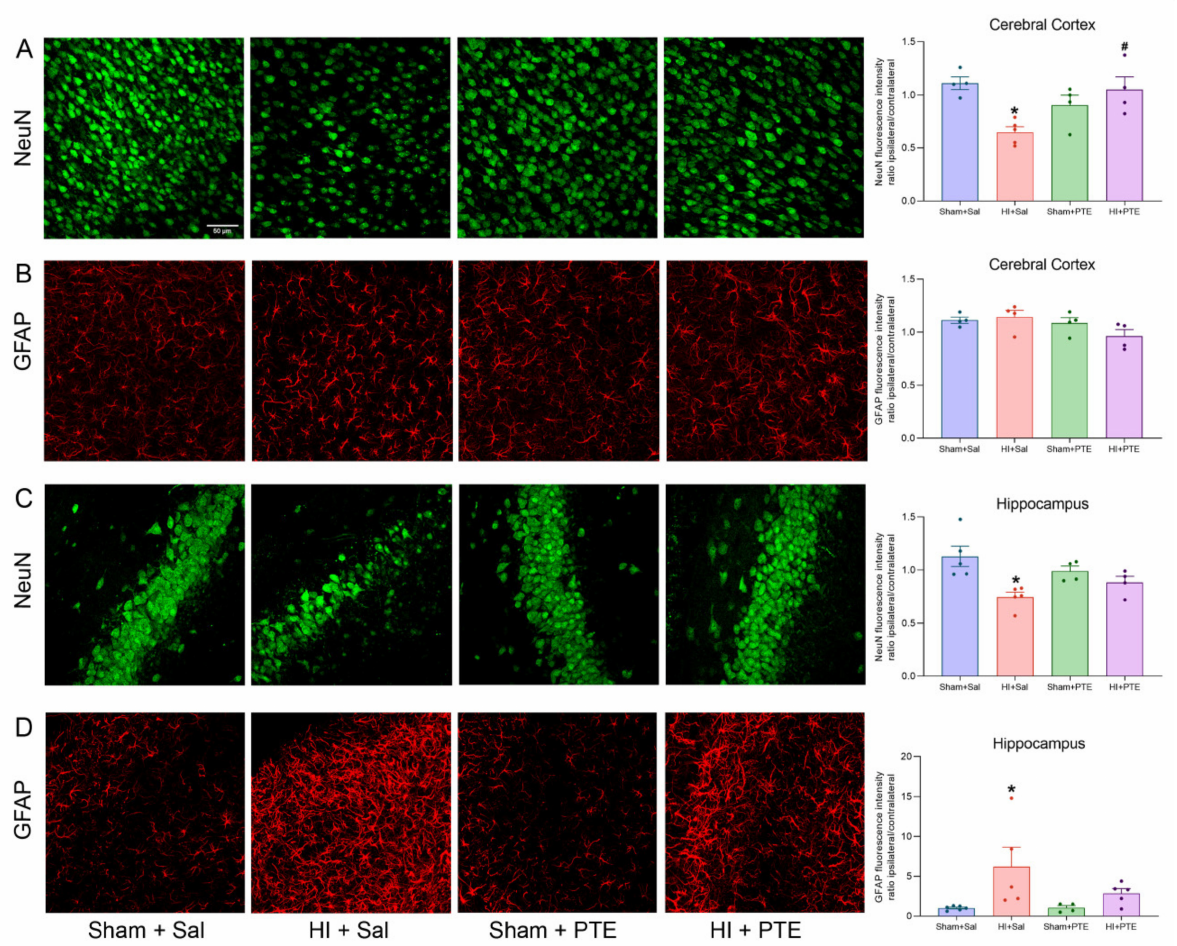
Figure 5. Representative immunofluorescence images showing NeuN ( A ) and GFAP ( B ) staining in the cerebral cortex; NeuN ( C ) and GFAP ( D ) staining in the hippocampus 72 h following neonatal HI. Data are expressed as mean ± SEM. Quantification of the fluorescence intensity of NeuN and GFAP was performed at 400 × magnification by using the mean of five randomly selected fields from each brain. * Injury effect (HI vs. control). # Treatment effect (Sal vs. PTE). Sham + Sal ( n = 4–6); HI + Sal ( n = 4–5); Sham + PTE ( n = 4); HI + PTE ( n = 4–5). Significance was accepted at p < 0.05 (* or #) (one-way